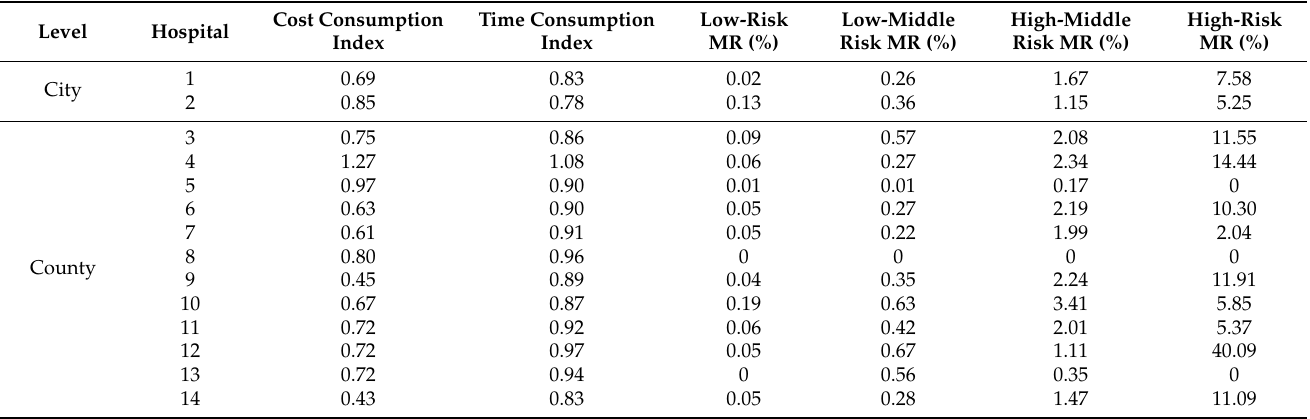
Table 2. Other baseline characteristics of sample